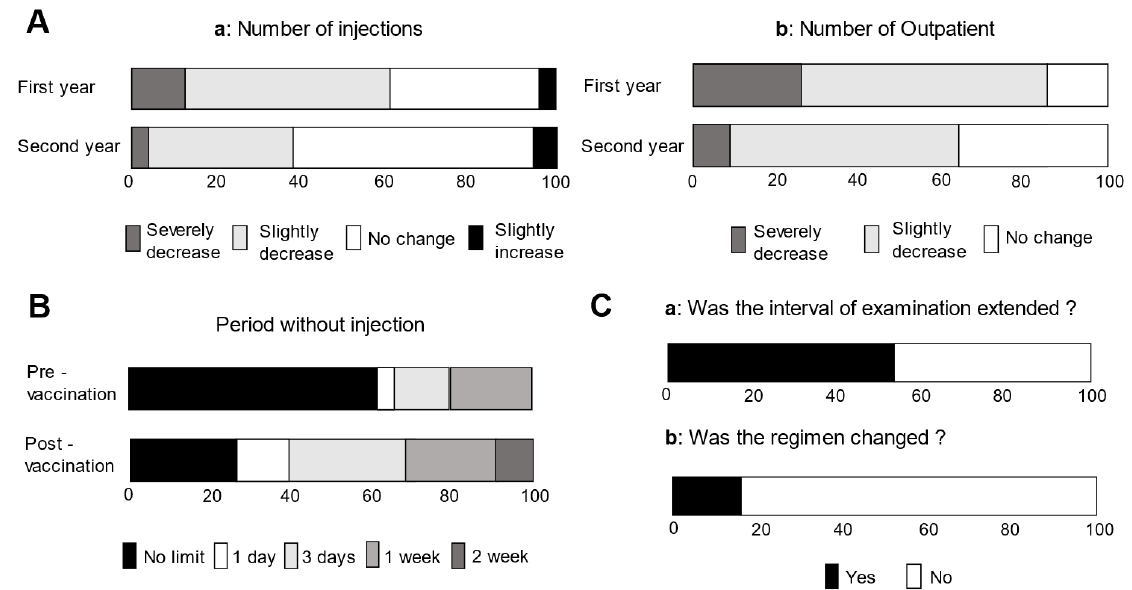
Figure 2. Distribution of responses to the questionnaires. ( A ) Responses to the question “Do you feel that the number of anti-VEGF injection ( a ) and number of outpatient visits ( b ) have changed as compared to pre-pandemic levels?” ( B ) Responses to the question “For what period of time before and after COVID-19 vaccination were intravitreal injections not administered?” ( C ) ( a ) Responses to the question “Did you extend the interval between patients’ visits to the ophthalmologist due to the COVID-19 pandemic?” and ( b ) Responses to the question “(4) Did you change the anti-VEGF treatment regimen for DME?”.